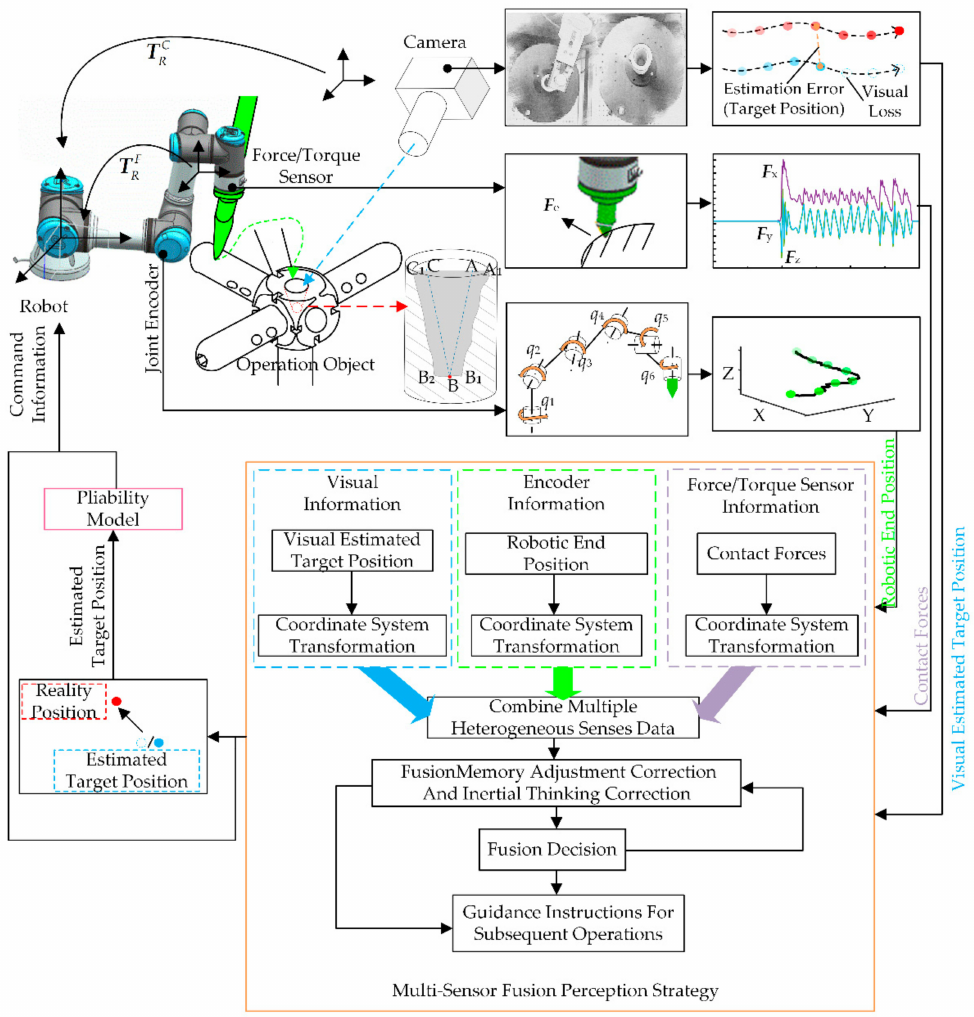
Figure 1. The solution scheme for robotic